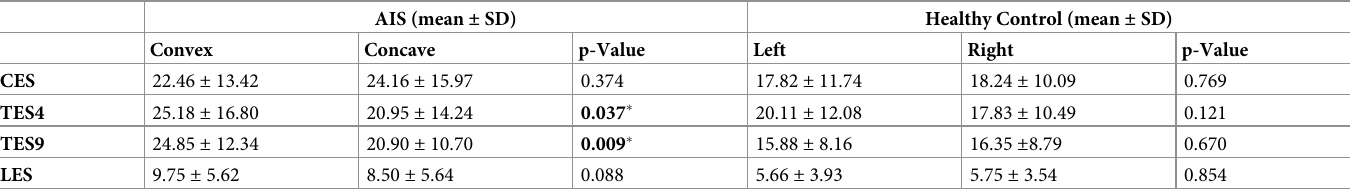
Cervical erector spinae (CES); Thoracic erector spinae at T4 (TES 4) and T9 (TES 9); Lumbar erector spinae (LES) � Indicates significant difference in %MVC (p < 0.05) between two sides, independent from the functional tasks and experimental (fatigue)